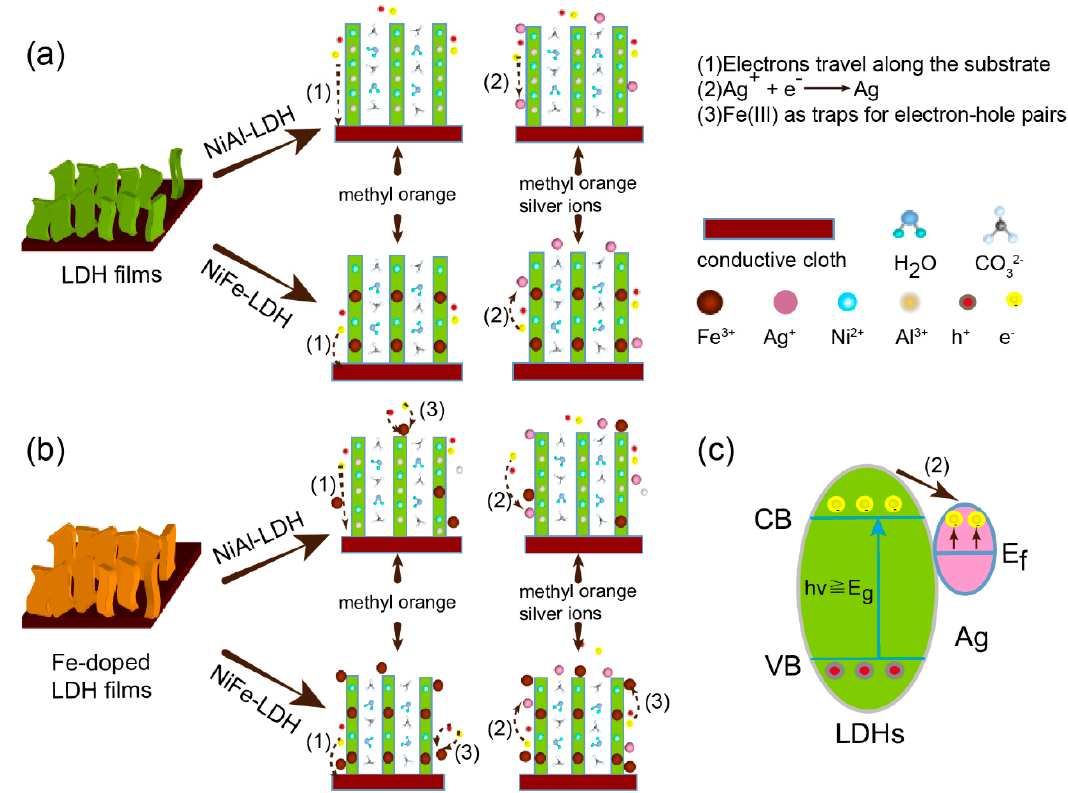
Figure 6. Schematic diagram of possible electron transport in ( a ) LDH films and ( b ) Fe-doped LDH films in degradation of methyl orange or a mixed solution of methyl orange and Ag ions. ( c ) Possible electron transport between LDHs and Ag nanoparticles.